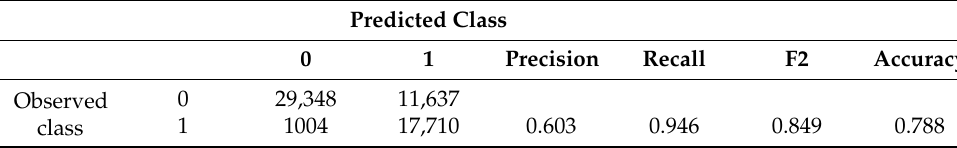
Table 3. Confusion matrix for RF-OS model with the test set.